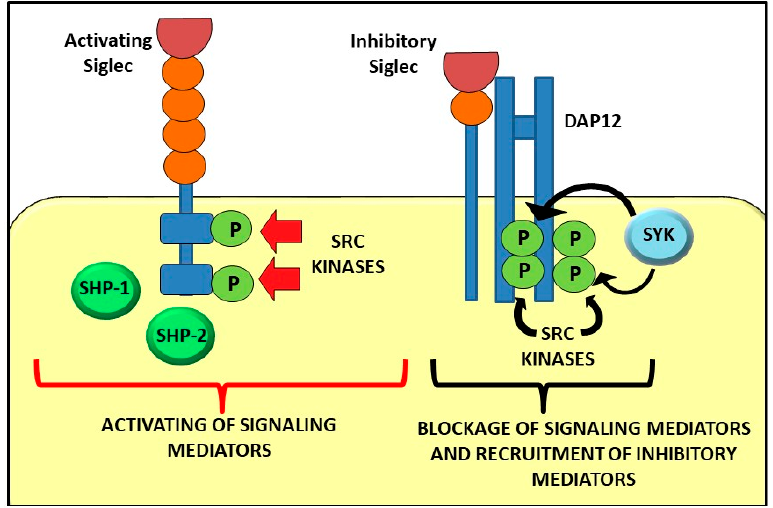
Figure 1. Signalling pathway mediated by activating and inhibitory Siglecs. The modulation of intracellular signaling can occur for example through the inhibi- tion of integrin-mediated signaling by Siglec-E in murine neutrophils [15]. Activating CD33-related Siglec receptors lack ITIMs, but they are characterized by a positively charged amino acid within the transmembrane domain implicated in the binding to DNAX-activating protein of 12 kDa (DAP12) [16]. The linkage between DAP12 and acti- vating Siglecs leads to the phosphorylation of the immunoreceptor tyrosine-based acti- vating motifs (ITAMs) of DAP12 and to spleen tyrosine kinase (Syk) activation [14,16].